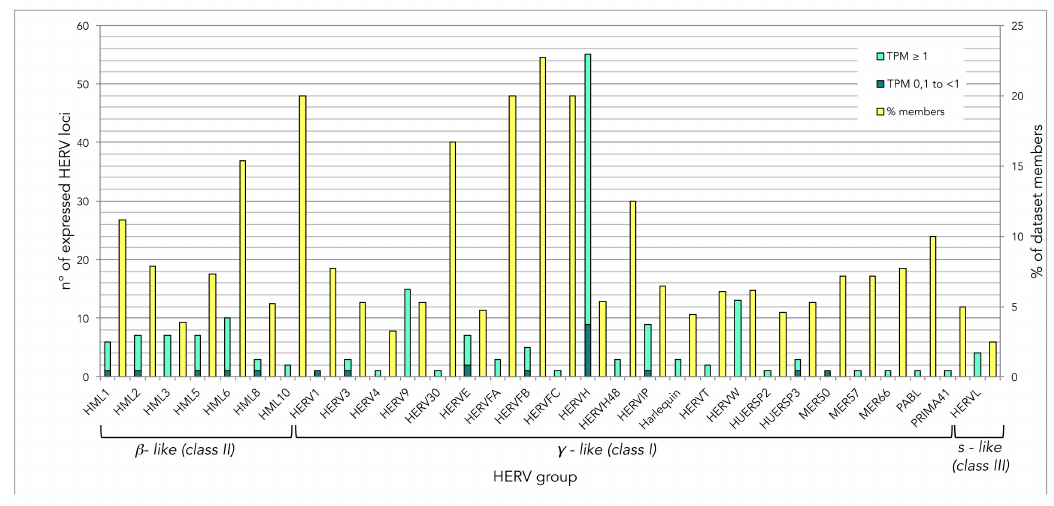
Figure 2. Landscape of HERV loci expressed (TPM value ≥ 0.1) in one or both conditions (HIV- and / or HIV + T cells), divided in taxonomic viral groups. The number of expressed members (left axis) as well as their percentage with respect to the group total members (right axis) are